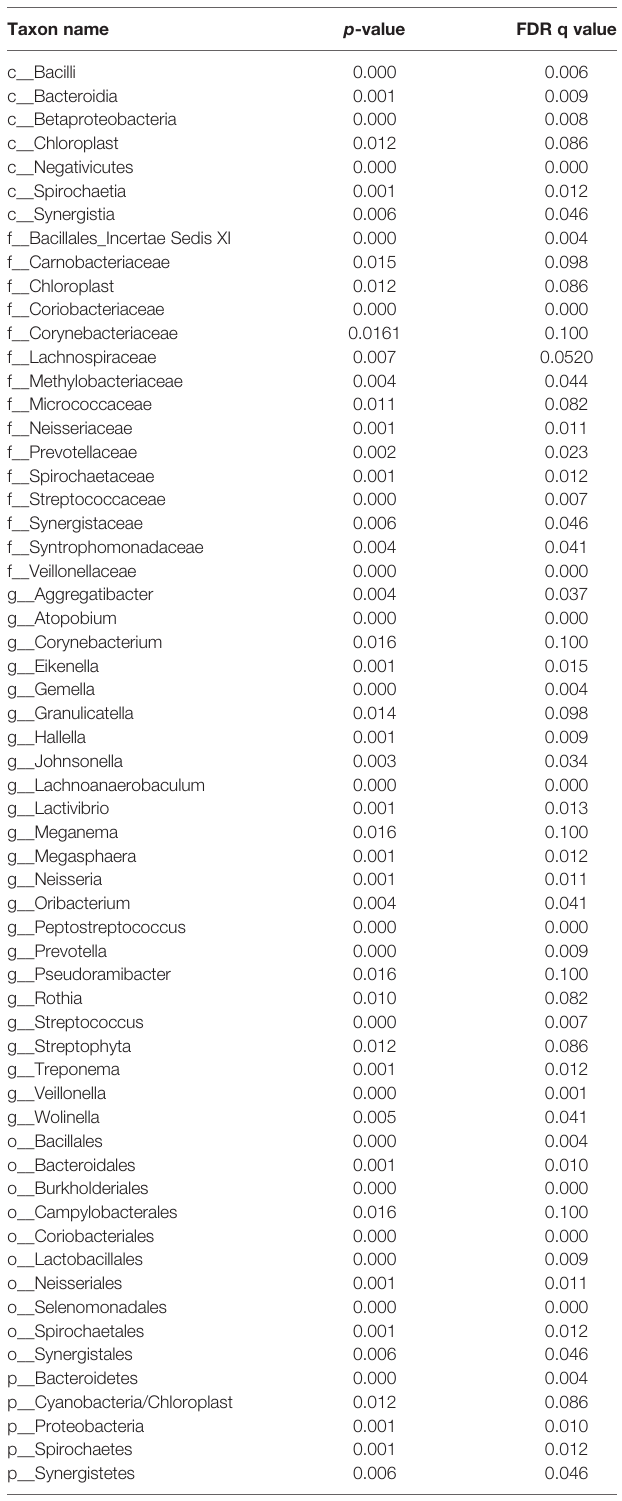
TABLE 2 | Relative abundance of RE and healthy controls(Only p -values <0.01 are